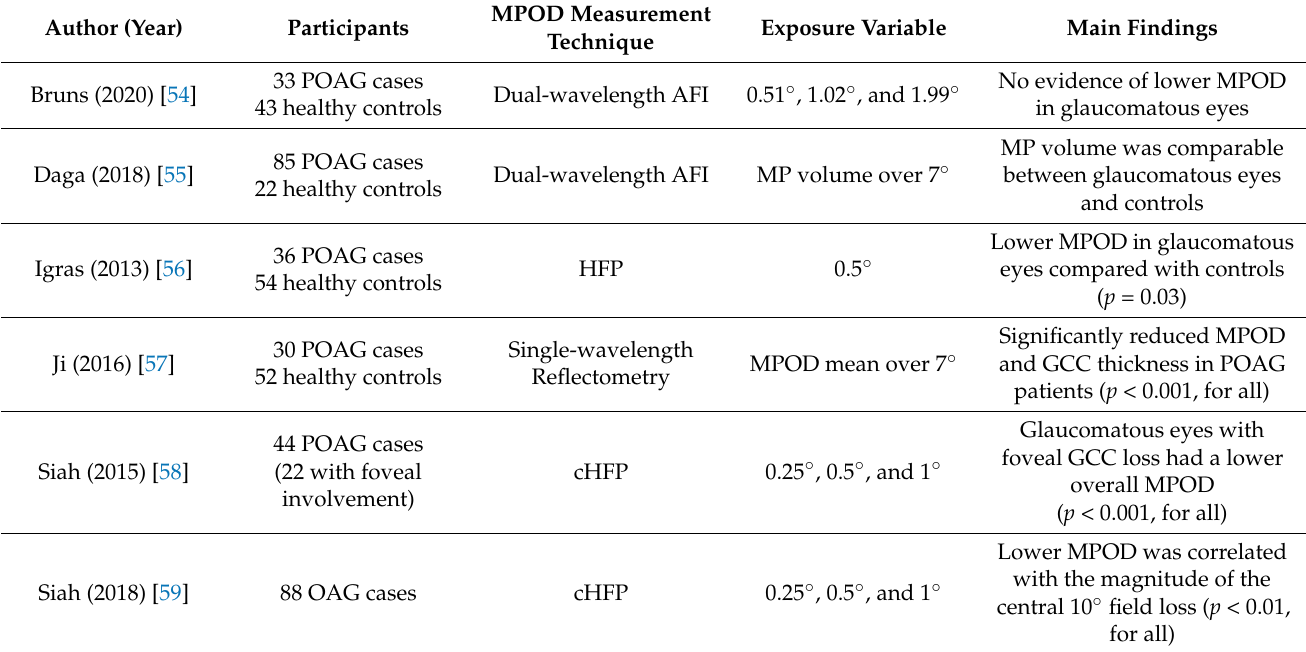
Table 2. Clinical studies evaluating macular pigment optical density (MPOD) in open-angle glaucoma. Author